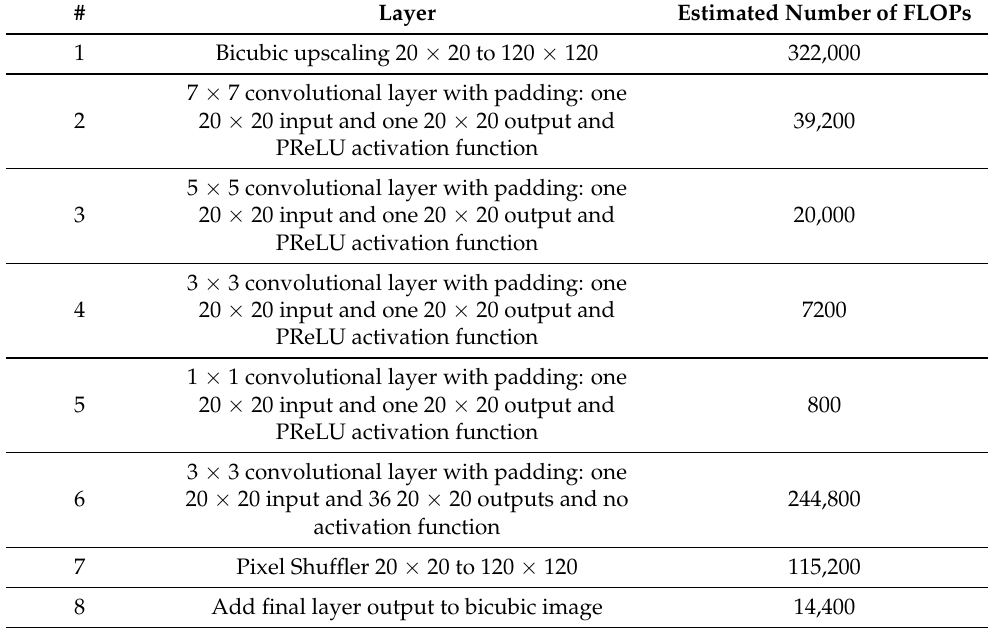
Table 1. Computational Cost Of CNN